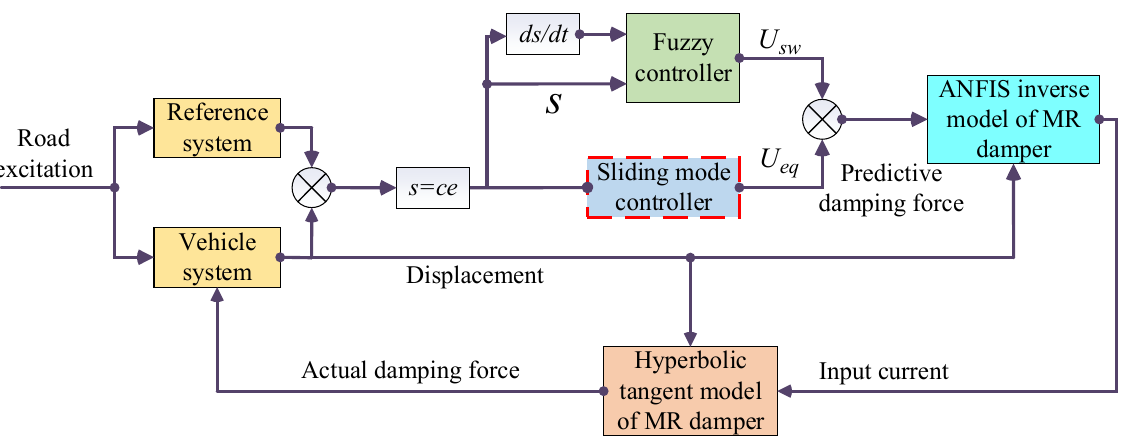
Figure 14. FSMC structure diagram of MR semi-active air suspension.